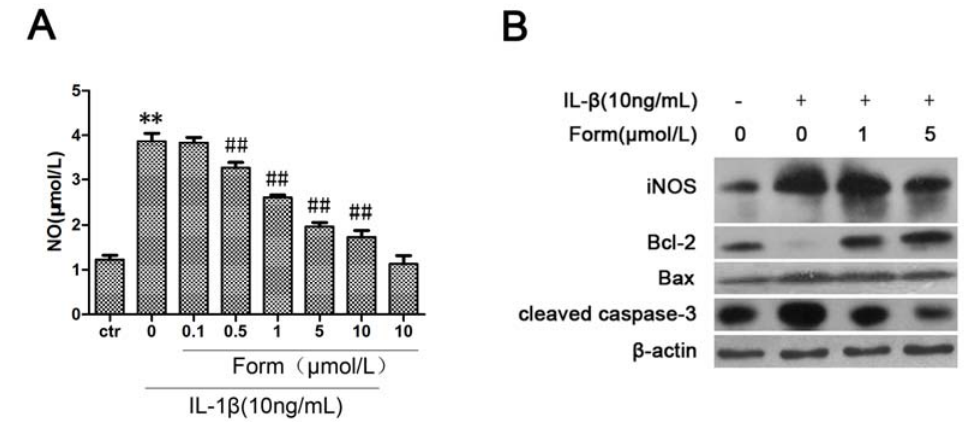
Figure 3. The effect of formononetin on IL-1 β -induced NO formation and apoptotic pathway in INS-1 cells. Cells were treated with the indicated concentrations of IL-1 β and formononetin for 24 h. ( A ) The level of NO in medium of INS-1 cells was determined using Griess method. Values are the means ± SD (n = 3) of three individual experiments. * p < 0.05, ** p < 0.01 vs . ctr (DMSO); # p < 0.05, ## p < 0.01 vs . group treated with IL-1 β excluding formononetin. ( B ) The expression of apoptotic genes were analyzed by western blot in INS-1